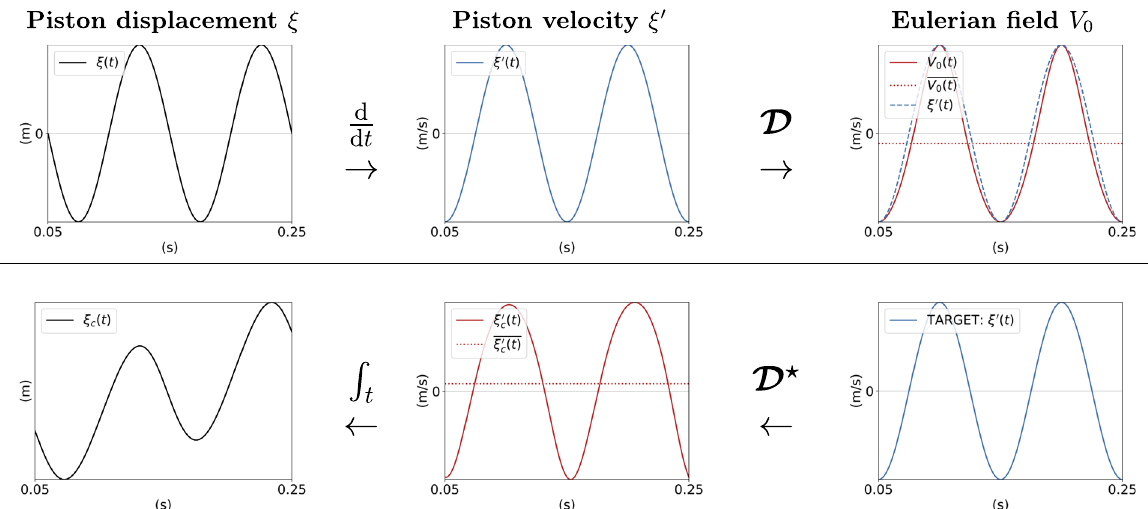
Figure 11. Illustration of the (slow) divergence of the displacement signal for a centered target Eulerian fi eld. The centered displacement signal n ð t Þ (top-left) generates an Eulerian fi eld V 0 ð t Þ (top-right) with a negative mean value. Therefore, a centered target Eulerian fi eld (down-right) requires a corrected piston velocity n 0 ð t Þ thas has a positive mean value (down-middle) and the c t Þ constantly increases with time (down-left). For the sake of illustration, calculations have been corresponding displacement n c ð carried out with exaggerated displacement amplitude of 1 m at 10 Hz.